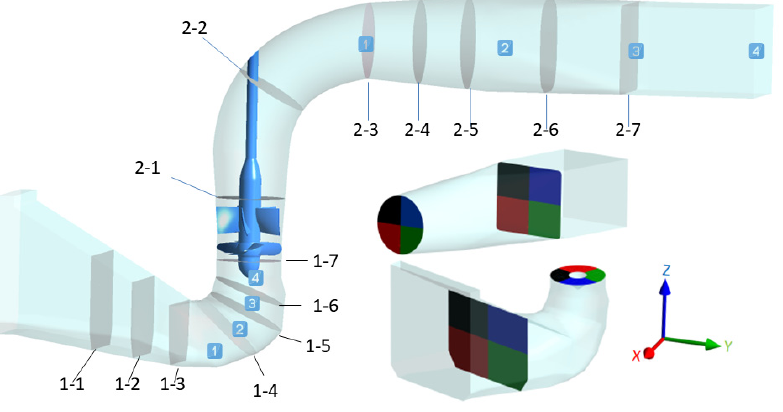
Figure 11. Schematic diagram of the cross section of the inlet and outlet conduits and the layout of monitoring points.